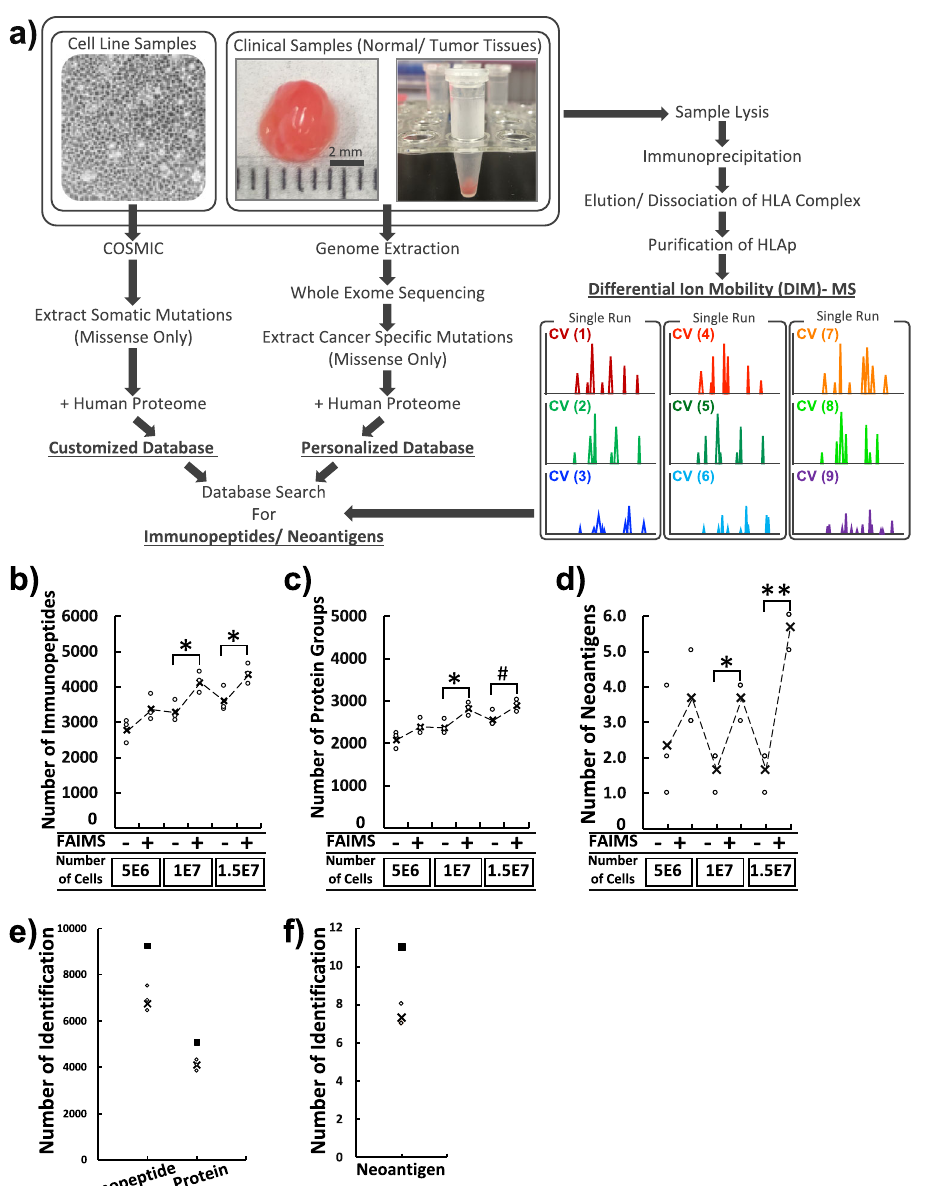
Fig. 1 A schematic work fl ow and validation of global-immunopeptidomics analysis by FAIMS-assisted DIM-MS. a The work fl ow for proteogenomic personalized immunopeptidomics analysis is shown. The DIM-MS analysis was performed with seamless gas-phase fractionations by installing the FAIMS- Pro interface. Acquired raw fi les were searched against the tailored database that includes the normal human proteome with sample-corresponding cancer- speci fi c somatic mutations. CV compensation voltage. b – d The dot-plots depict the number of identi fi cation of immunopeptides, source proteins, and neoantigens in HCT116 cells respectively. The open circles indicate individual data points of three replicates. X indicates the average number of identi fi cation from the replicates. Filled box indicates total number of identi fi cation from the replicates. The dashed line represents the transition of average number of identi fi cation. # p < 0.1, * p < 0.05, ** p < 0.01. e , f The dot-plots depict the number of immunopeptides, source proteins, and neoantigens identi fi ed in HCT116 cells by global-immunopeptidomics analysis. The number of immunopeptides identi fi ed from three independent analyses using 1e8 HCT116 cells. The open circles indicate individual data points of three independent analyses. X indicates the average number of identi fi cation from the analyses. Filled box indicates total number of identi fi cation from the proteins (Fig. 1e, Supplementary Data 1c). The representative results of immunopeptidomics analysis of HCT116 cells with respect to the CV distribution and the overlap are shown in Supplementary Fig. 3. The typical length (9 – 15 amino acids) of class I immunopeptides and the reasonable assignment of iden- ti fi ed immunopeptides for the corresponding HLA allotype of HCT116 were observed within the immunopeptidome (Supple- mentary Fig. 4). From this immunopeptidome, an average of 7.3